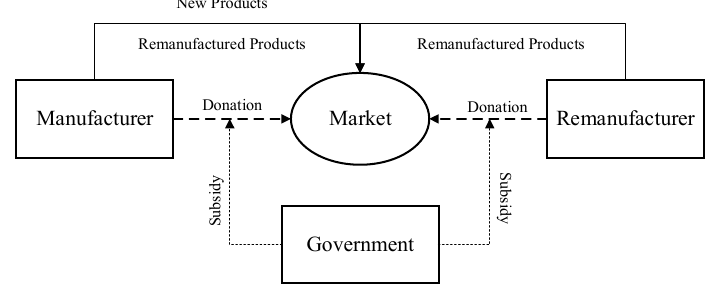
Figure 1. Model structure.